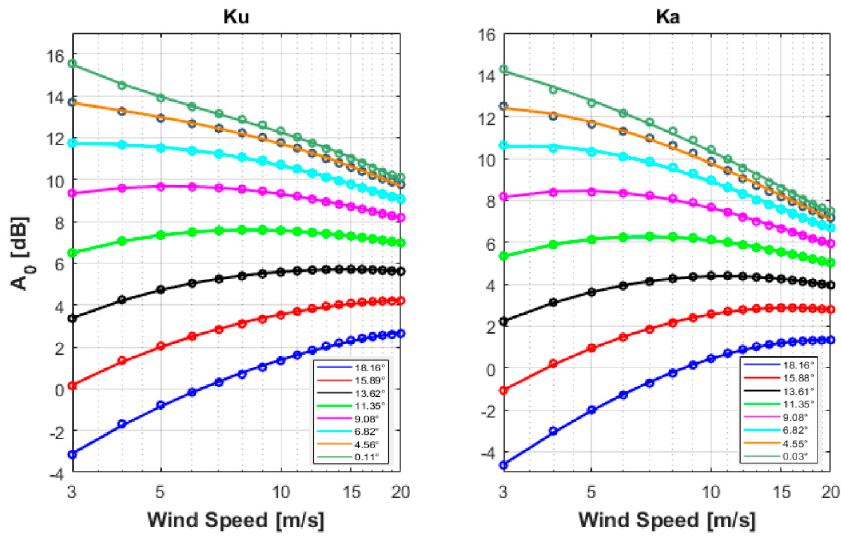
Figure 4. Isotropic σ 0 models ( A 0 coefficients in dB) of KuPR ( left ) and Ka-band precipitation (KaPR) ( right ) as a function of wind speed (3–20 ms − 1 ) at different earth incidence angles (0 ◦ –18.1 ◦ ). The symbols are mean values of binned σ 0 measurements while the solid lines represent their 3rd order regression